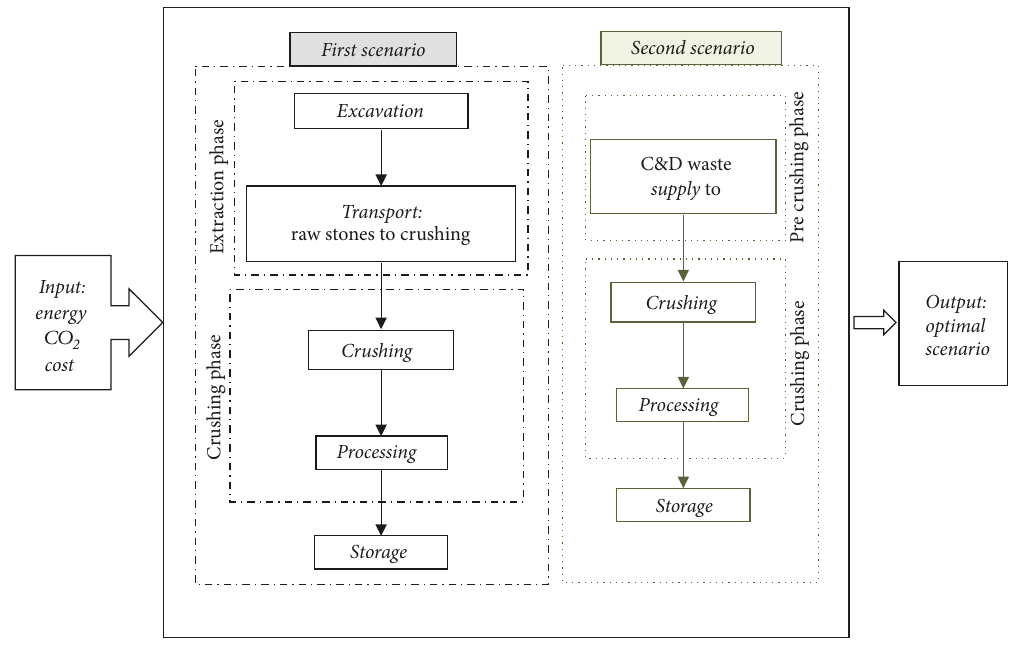
Figure 2: Life-cycle sketch of aggregates